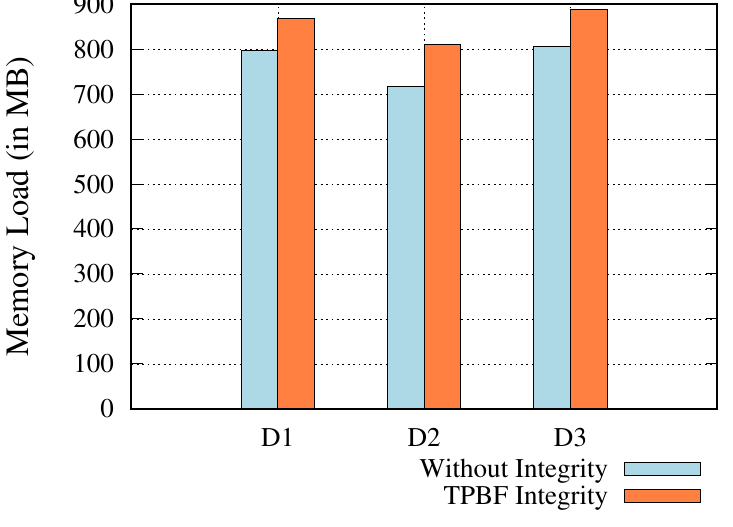
Figure 10. Memory usage.